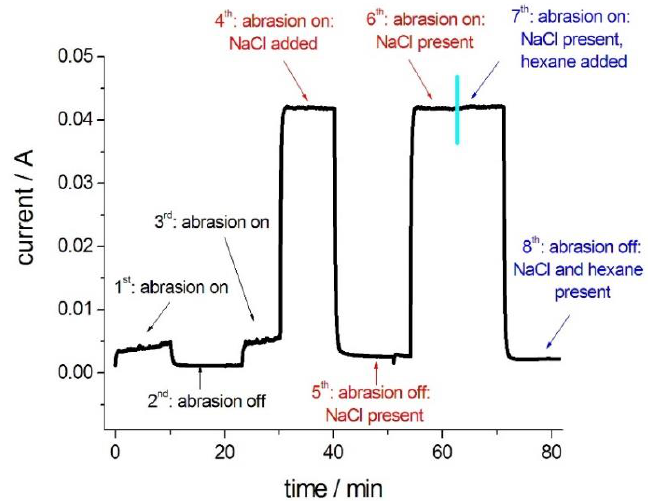
Figure 12. A typical abrasion–corrosion testing sequence under electrochemical control, see Section 3.3 for details.